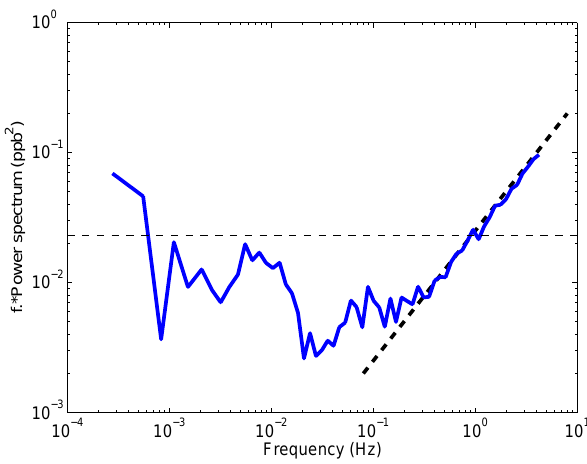
Fig. 14. One-hour average ozone spectrum from DOY 210, 11:00 GMT during TexAQS-2006. The horizontal dashed line indicates the white noise level at 2.3 × 10 − 2 ppbv 2 Hz − 1 , and the bold dashed line shows a slope of +1 speed U was ∼ 8 m s − 1 with a mean friction velocity u ∗ of